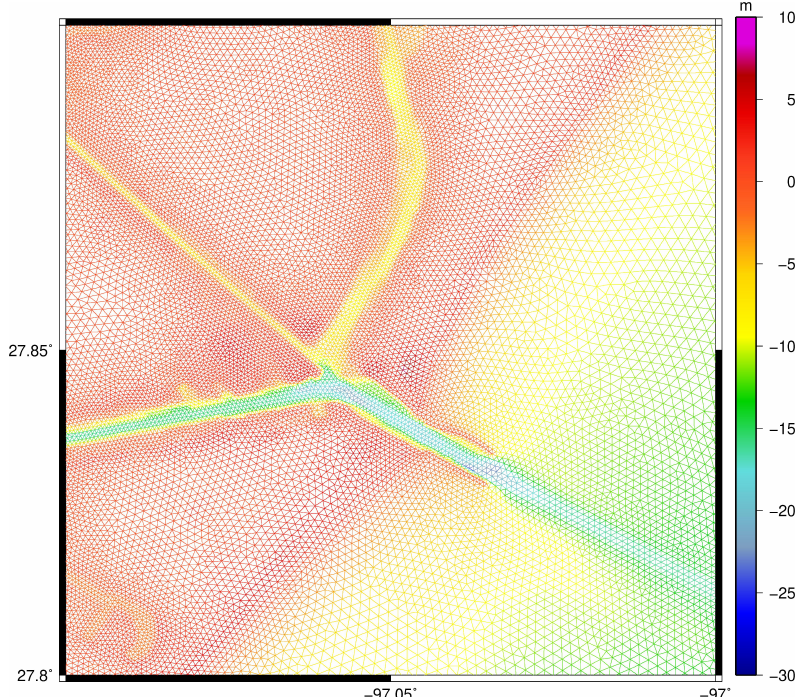
Figure 5. Mesh resolution in the Aransas Pass, the color bar denotes bathymetric depth of the exiting channel.